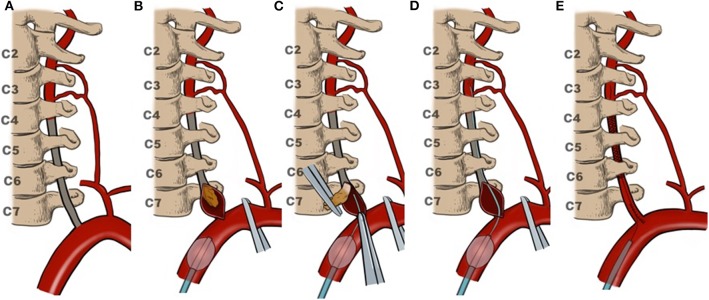
Illustration of VA recanalization. (A) Occlusion involved the V1and V2 segment; (B) endarterectomy for V1segment first; (C) delivering microcatheter and microwire along with the interface between the plaque/thrombus and vessel wall; (D) microcatheter angiography confirming the distal VA real lumen; (E) closing V1 incision then stenting for the V2 segment.